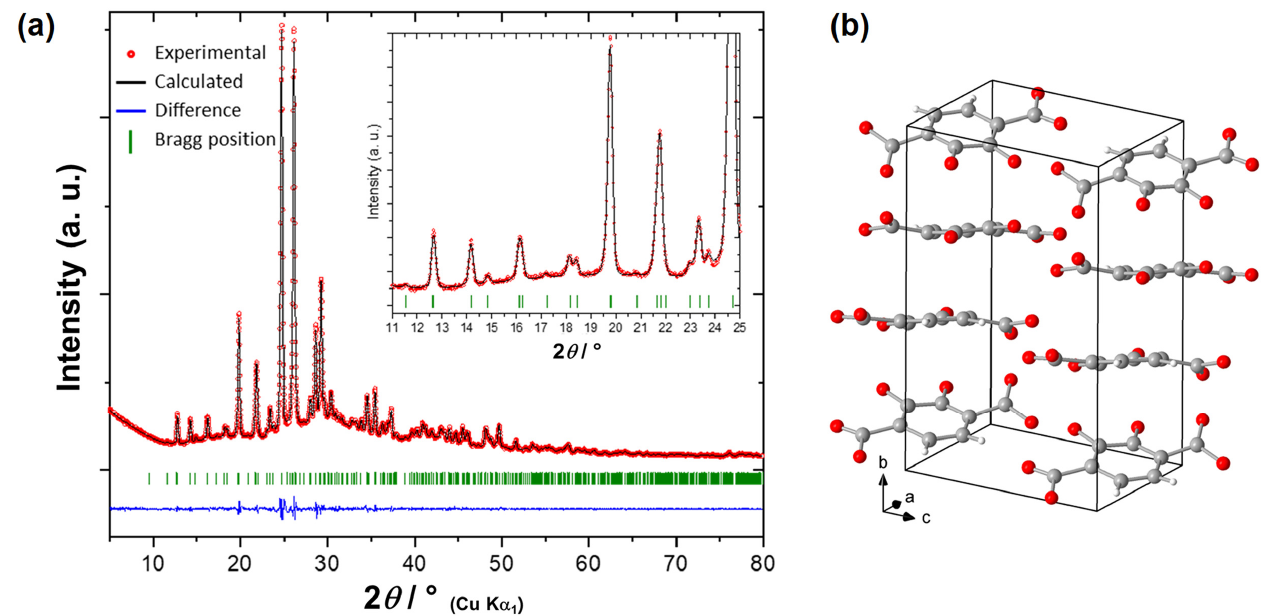
Figure 5. ( a ) Le Bail refinement of the PXRD of the Li 4 - o -DHT ( β -phase). The inset shows the good agreement between the experimental diffraction peaks and the Bragg positions at the low 2 θ angles. ( b ) Location of the o -DHT unit (C 8 H 2 O 6 ) in the monoclinic lattice as obtained by the FOX software.